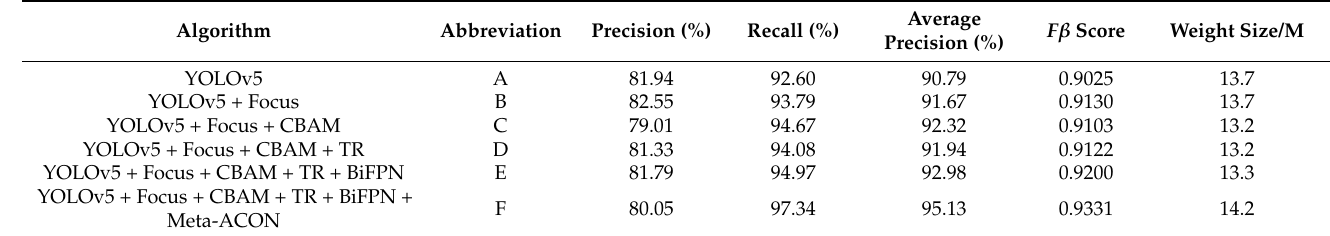
Table 3. Ablation test results of different algorithms.